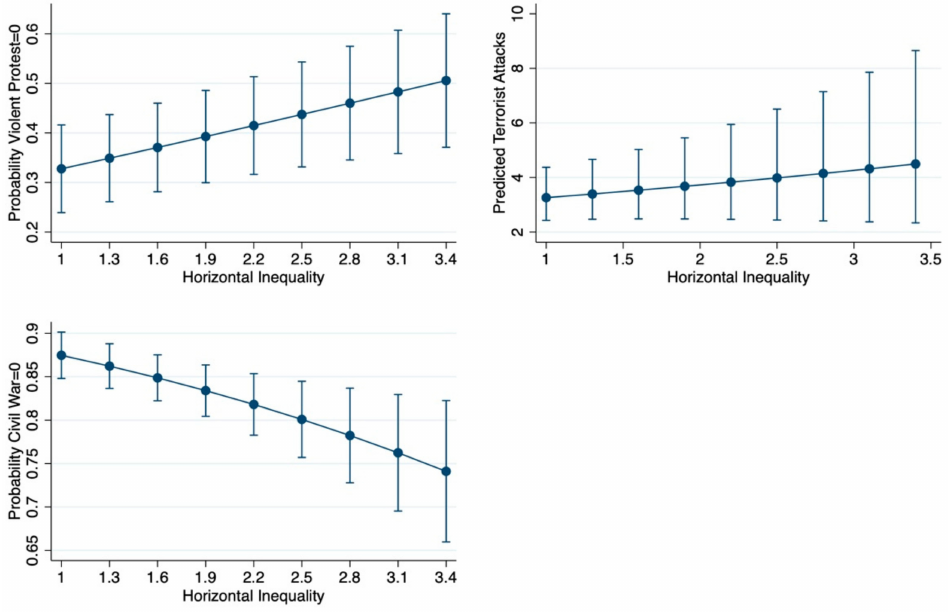
Figure 5. Negative horizontal inequality and